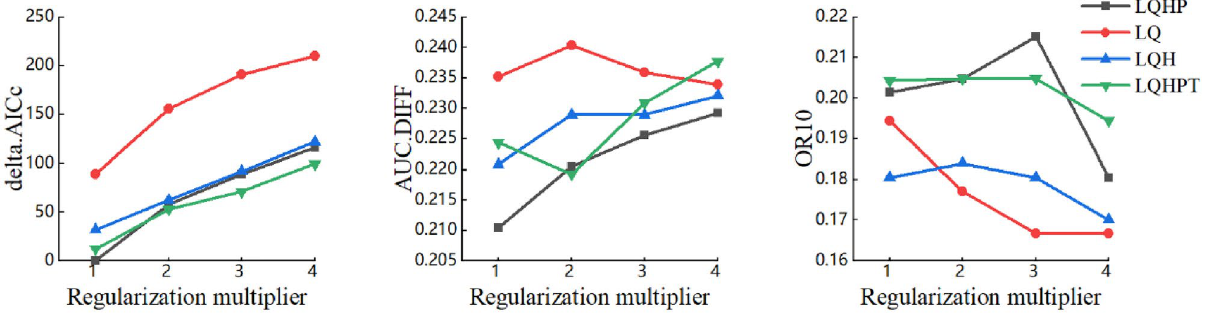
Figure 2. Assessment metrics of MaxEnt generated by